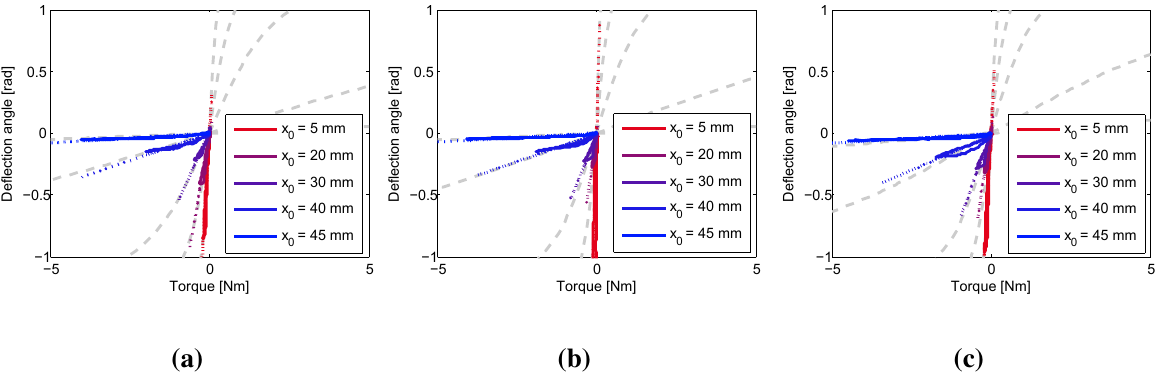
Figure 15. Stiffness/support location plots for a single-leaf spring based on a linear least squares approximation to the deflection/torque data. ( a ) Uniform; ( b ) negative parabola; ( c ) positive